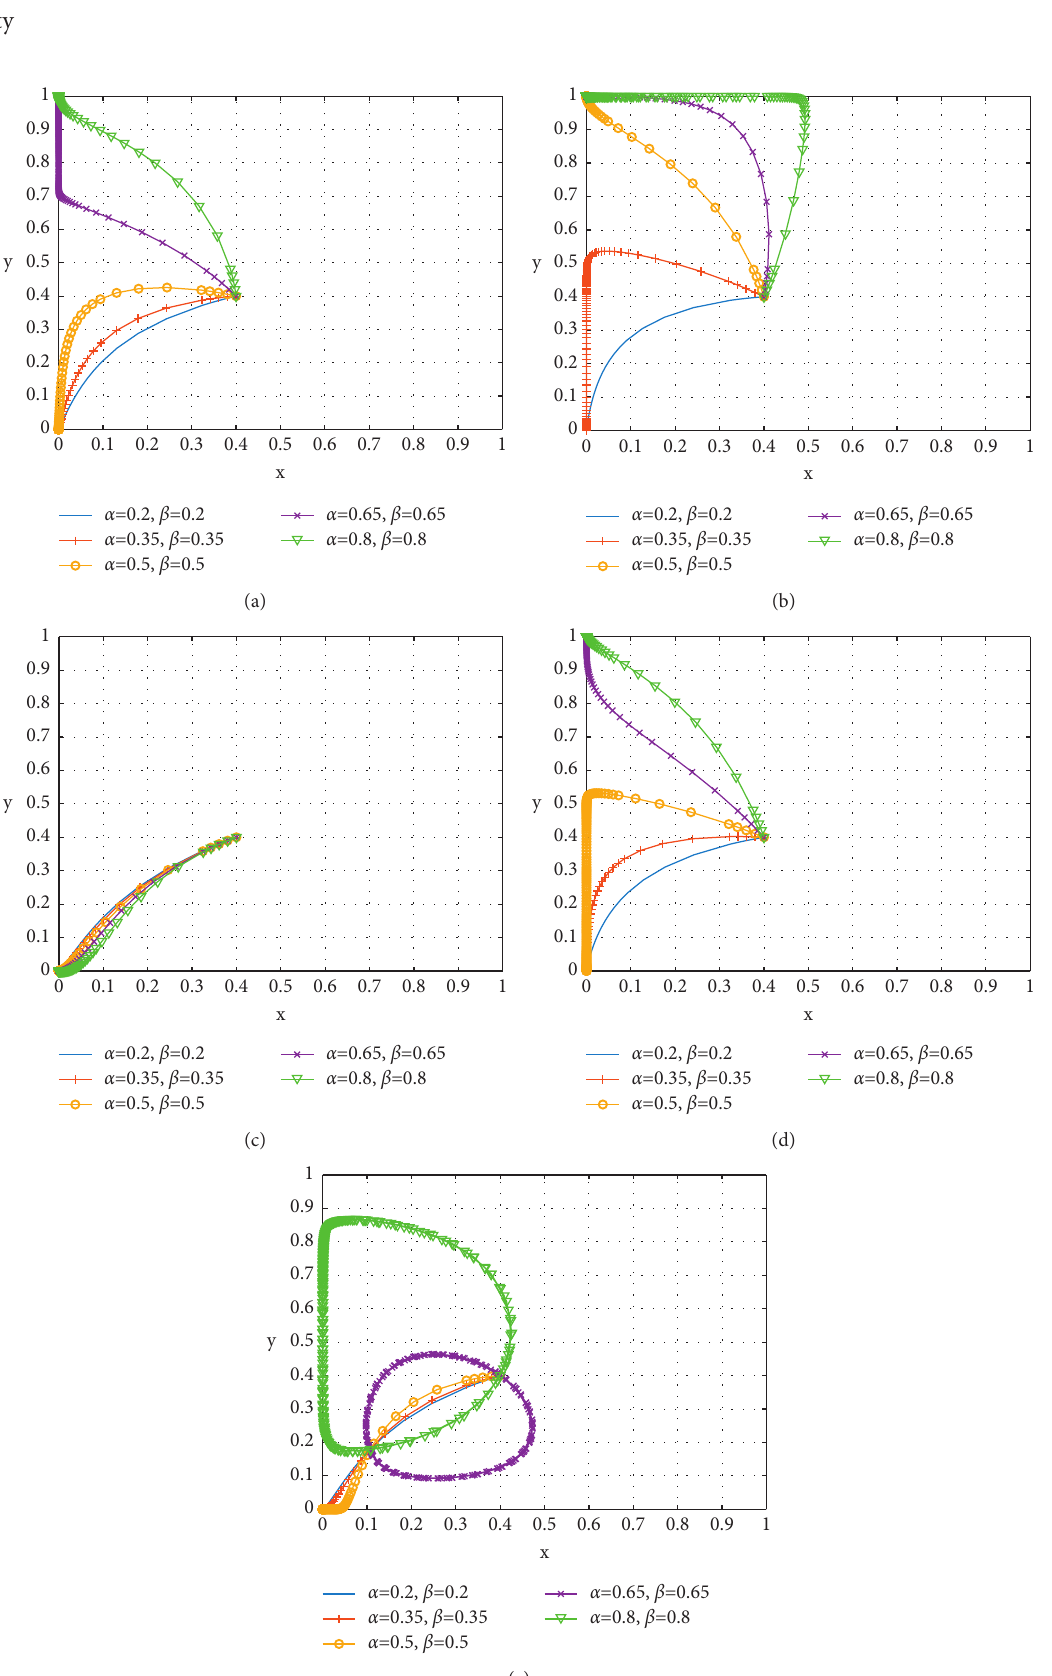
� 0 , A � 0. (b) A � − 1 , A � − 1. p s p s